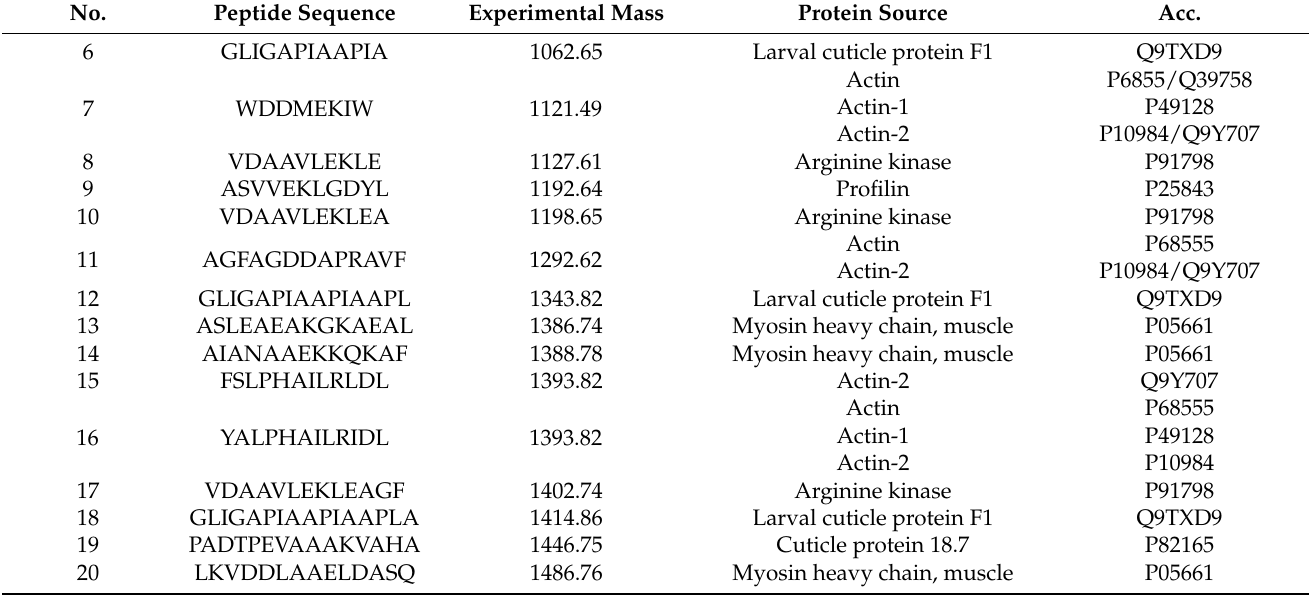
Table 2. Amino acid sequences of peptides from larvae protein extract hydrolysate determined